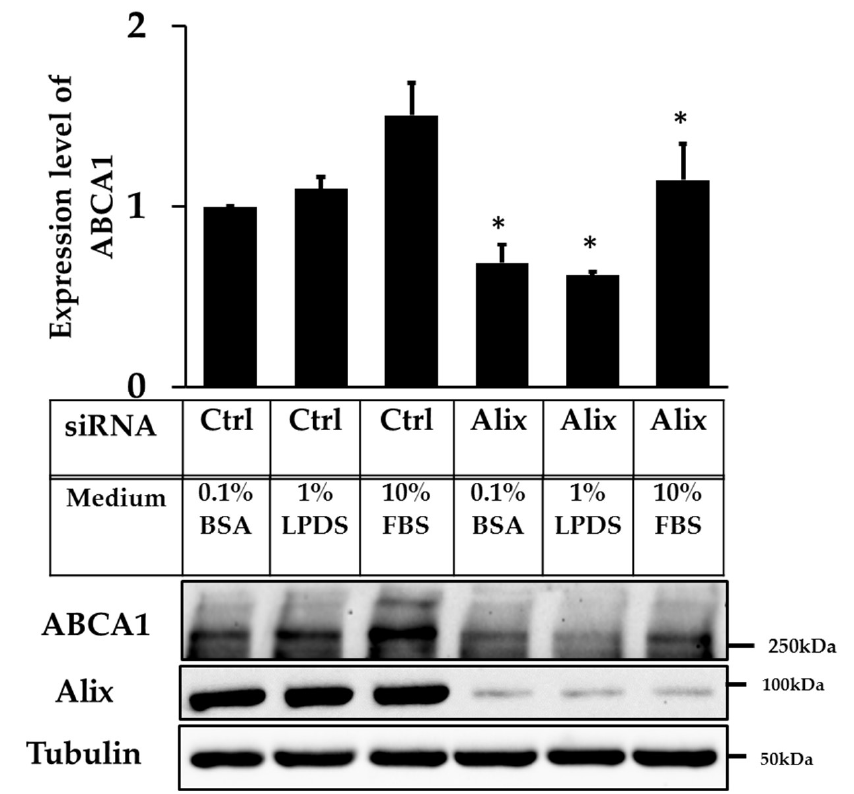
Figure 5. siRNA knockdown of Apoptosis-linked gene 2-interacting protein X (Alix) decreases ABCA1 protein expression. Quantification of ABCA1 protein relative to tubulin in low and normal serum conditions in ABCG1-CHOK1 (mean ± SEM of 4 individual data points from three independent experiments, expressed as fold change compared to control 0.1% BSA). * indicates p < 0.05 compared to control.